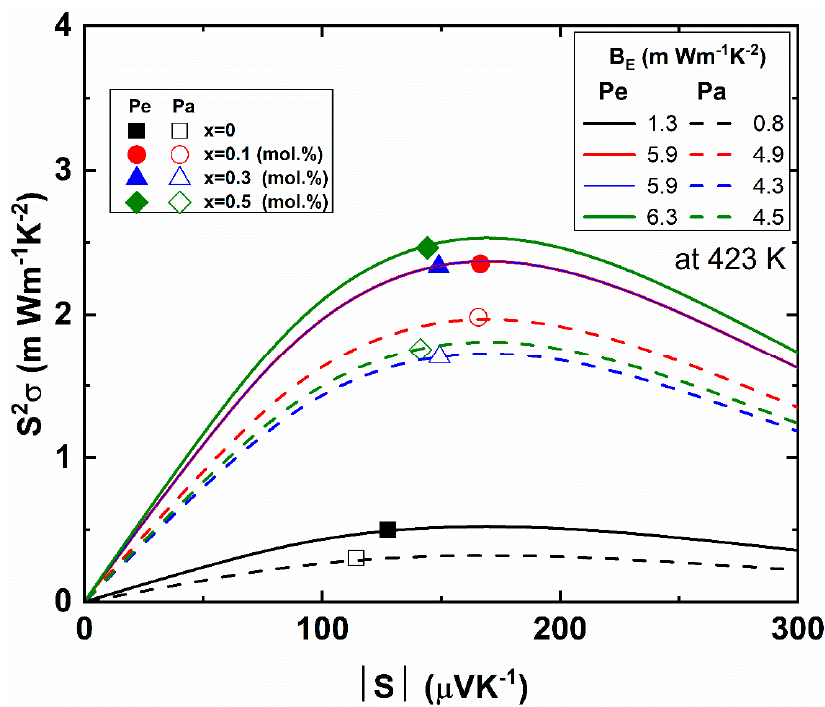
Figure 7. Power factor S 2 σ versus absolute Seebeck coefficient. Open and closed symbols are parallel (Pa) and perpendicular (Pe) directions for the pressure direction of the Bi 2 Te 2.85 Se 0.15 I x (x = 0.0, 0.1, 0.3, 0.5 mol.%) compounds. Full and dashed lines are theoretically calculated power factor S 2 σ along the Pe and Pa directions, respectively, with respect to the estimated electronic quality factor B E , as indicated in the